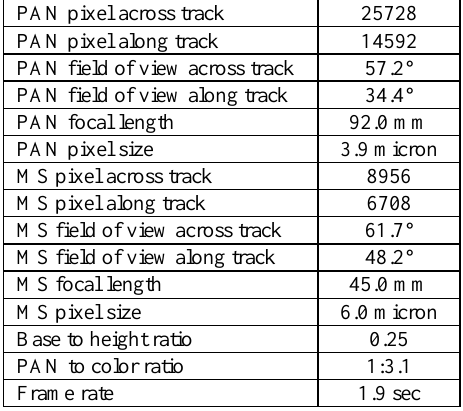
Table 1 DMC III camera specification